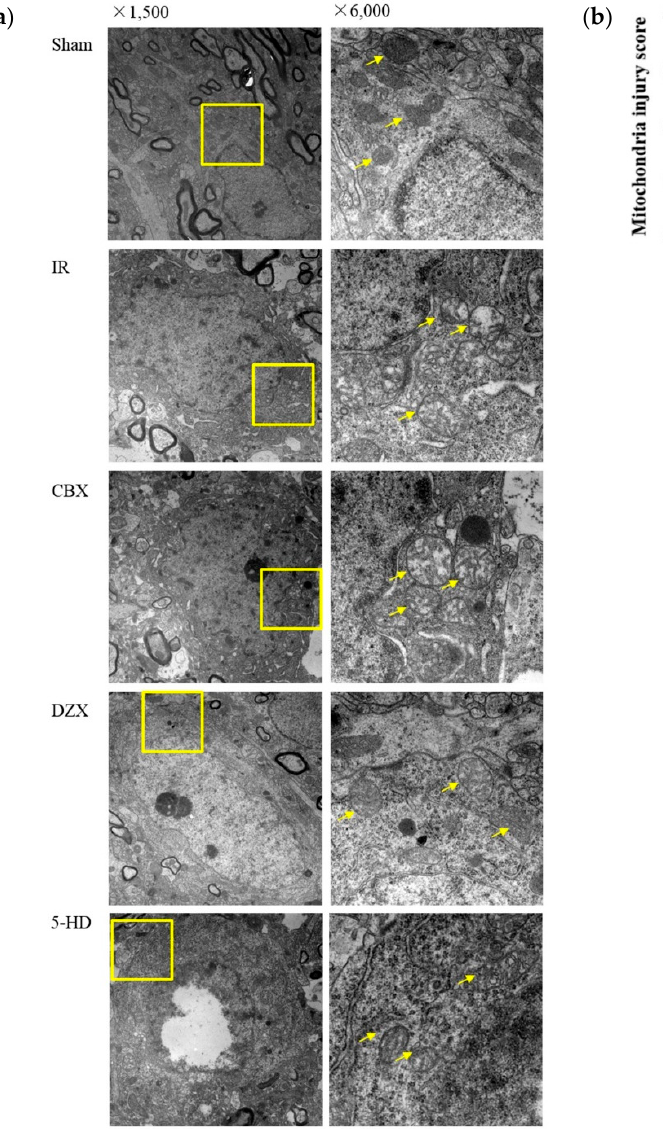
Figure 3. Effect of the mitoKATP channel on mitochondrial ultrastructures in the cortex after I/R injury. ( a ) Mitochondrial ultrastructure in different groups by transmission electron microscopy. The right picture is the zoomed view of the yellow box in the left picture. Mitochondria are indicated with the yellow arrows; ( b ) Scores for mitochondrial injury in different groups. Data are presented as mean ± standard deviation ( n = 3 in each group). F = 46.68, p ≤ 0.05; a p ≤ 0.01 vs. Sham; b p ≤ 0.01 vs. IR; c p ≤ 0.05 vs. DZX. 5-HD: 5-hydroxydecanoic acid; CBX: carbenoxolone; DZX: diazoxide; IR: ischemia-reperfusion.